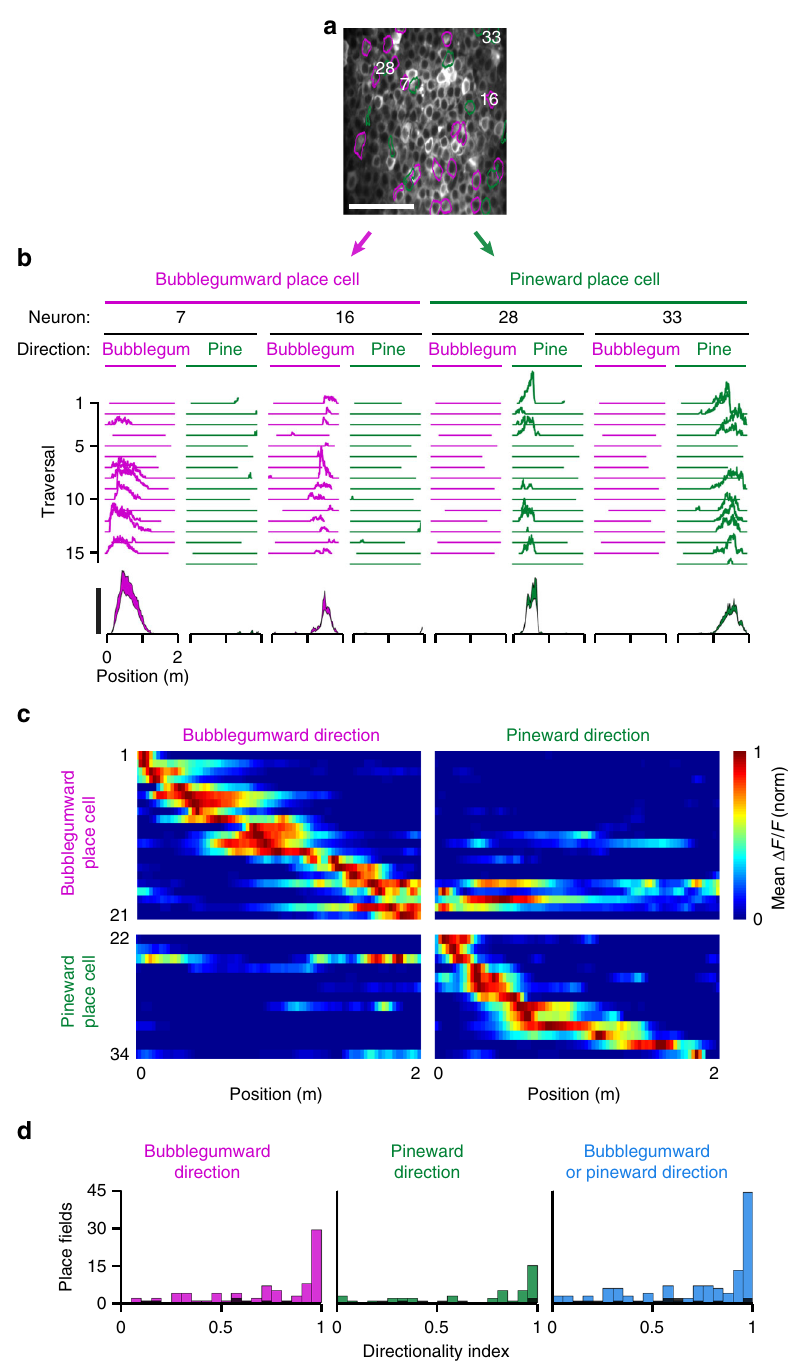
Fig. 5 CA1 place cells during olfactory-guided virtual navigation tend to exhibit directional preferences. a Averaged fi eld of view of CA1 stratum pyramidale during olfactory-guided virtual navigation. Each signi fi cant place cell is outlined with the color indicating the direction in which its place fi eld occurred. Scale bar = 100 µ m. b Traversal-by-traversal (top, arbitrary units) and mean change in fl uorescence (bottom, Δ F / F , mean±s.e.m). for each neuron numbered in a during traversals in its preferred and non-preferred direction. Scale bar = 100% Δ F / F . c Normalized mean Δ F / F as a function of track position for each place cell outlined in a during runs in its preferred and non-preferred direction. d Histograms of all place fi eld directionality indices during traversals in the bubblegumward direction (left), the pineward direction (middle), or either direction (not both directions) (right), pooled from seven mice, one session per mouse. Colored bars represent the dark odor condition and black bars represent the dark fl at condition for the same fi elds of view during the same behavioral